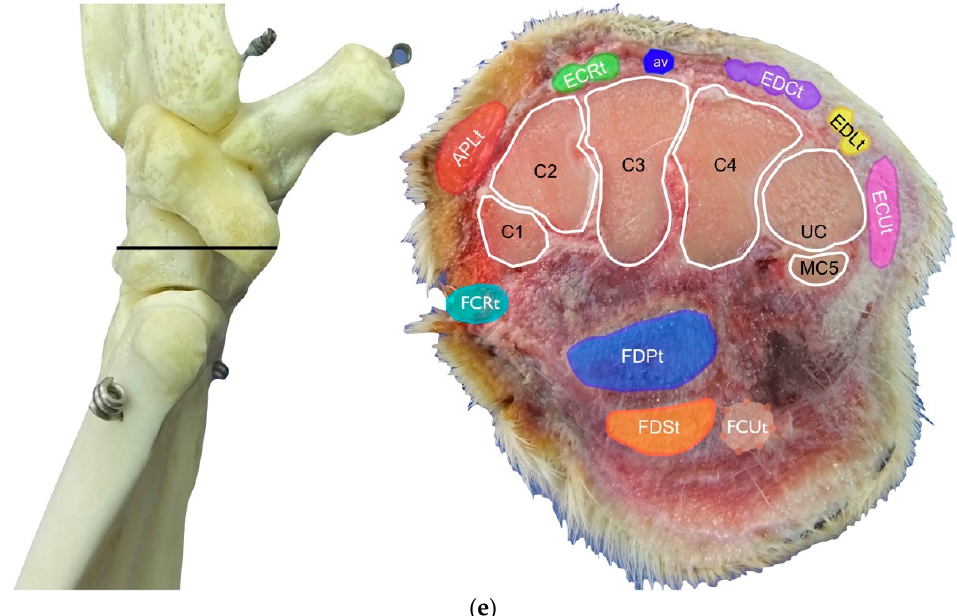
Figure 1. ( a ) Dorsal carpal face. The ulnar notch of the radius (UN) is palpated, and the tendon of the Abductor Pollicis Longus (APLt) and the adjacent Extensor Carpi Radialis (ECRt) are found. The grooves beneath are labelled in the bone specimen (APLg and ECRg). The tendon of the Extensor Digitorum Communis (EDCt) and the small Extensor Digitorum Lateralis (EDLt) are easily palpated and visualised on the dorsolateral face. The corresponding grooves are labelled in the bone specimen. ( b ) The large tendon of the Extensor Carpi Ulnaris (ECUt) is easily visualised on the lateral carpal face. ( c ) On the palmar carpal face, the two heads (humeral and ulnar) of the Flexor Carpi Ulnaris tendon (FCUt) are easily seen, ending at the accessory bone. On this specimen, part of the ulnar head of the Flexor Carpi Ulnaris tendon (FCUut) was removed to show the humeral head of the same tendon (FCUht). Medially, the tendon of the Flexor Digitorum Superficialis (FDSt) is visible and is hiding the deeper Flexor Digitorum Profundus (FDPt) (white arrow). The tendon grooves are labelled on the osseous specimen. ( d ) The medial carpal face. The FDSt has been displaced laterally to expose the FDP tendon beneath. The tendon of the small Flexor Carpi Radialis tendon (FCRt) is visible between the FDPt and the tendon of the APL, and ( e ) transverse section of the front limb at the level of the distal carpal row, ventral to the base of the accessory bone. The topographic location of the tendons is visible. In this image, the virtual location of the FCUt has been drawn to give an overview of the corresponding position of all the carpal tendons. However, in reality, the tendon ends proximally at the base of the accessory bone. av, accessory cephalic vein; C1, carpal bone one; C2, carpal bone two; C3, carpal bone three; C4, carpal bone four; UC, ulnar carpal bone; MC5, fifth metacarpal bone.